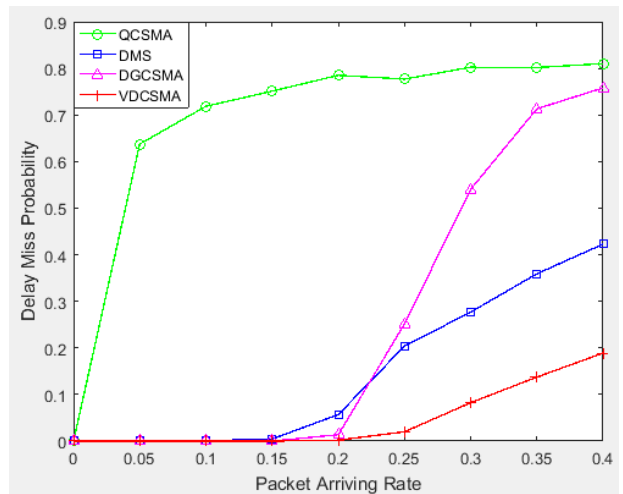
Figure 7. Delay missing probability of real-time links: λ ∈ [ 0,0.4 ] .